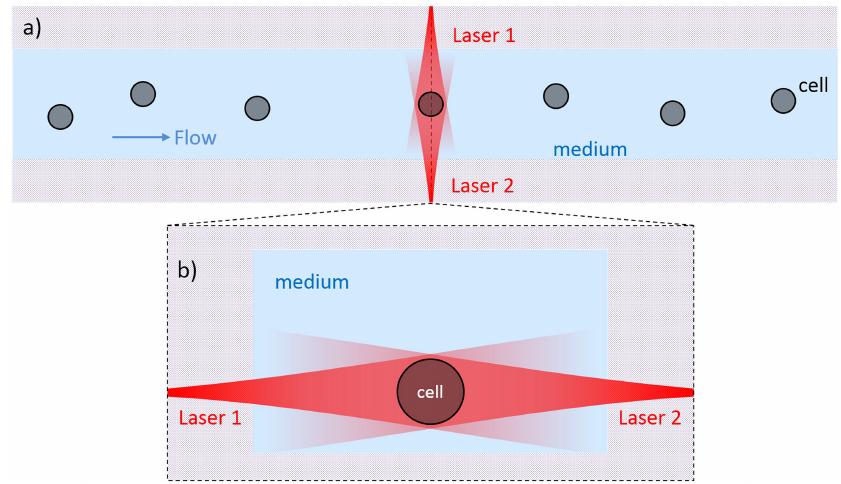
Figure 1. Schematic structure of an optical stretcher. ( a ) Top view of the central fluidic channel with flowing cells and a single cell trapped in the middle of the two opposing laser beams; ( b ) Cross section of the trapping area as indicated by the dash line in ( a ). The two opposite laser beams are positioned close to the channel